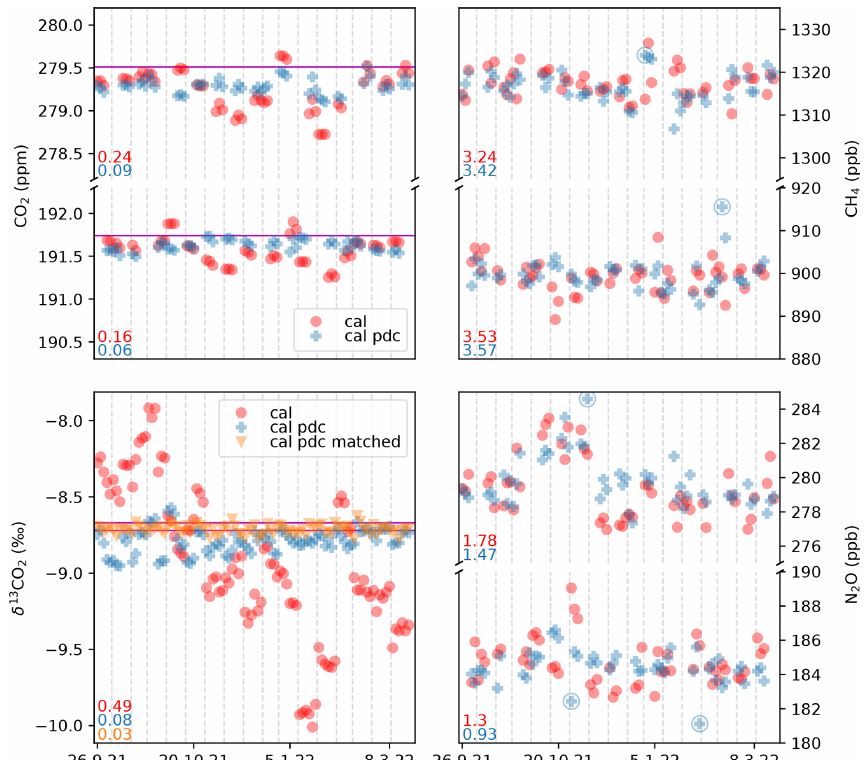
Figure 8. Repeated biweekly measurements ( n = 49) of B3 and B4 over 6 months. The two standards differ significantly in all measured concentrations but are essentially identical in δ 13 CO 2 (Table 1). Each measurement set, separated by the dashed gray lines, is composed of three aliquots of each standard. Data are shown as calibrated only (cal) as well as calibrated and drift-corrected (cal and pdc) according to Eqs. (1) and (2). For δ 13 CO 2 , drift-corrected values using the concentration-matched standard (cal pdc matched) are shown additionally. On the lower left of each subplot, the standard deviation (1 σ ) achieved with the different corrections is shown. For δ 13 CO 2 , the standard deviation is shown for the combined measurements of both standards. The circled symbol denotes an outlier identified in the secondary (“reference”) channel (more details in the main text). Outliers are not removed from the standard deviation, and hence our precision estimates based on these measurements are conservative. The horizontal magenta lines depict the externally determined values as listed in Table